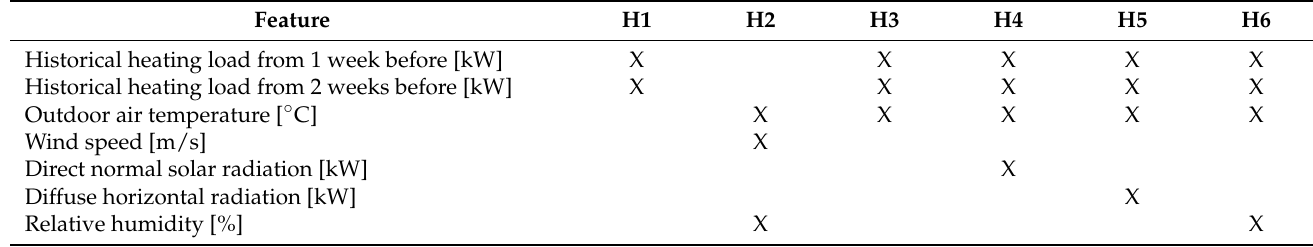
Table 2. Sets of features tested for heating energy demand